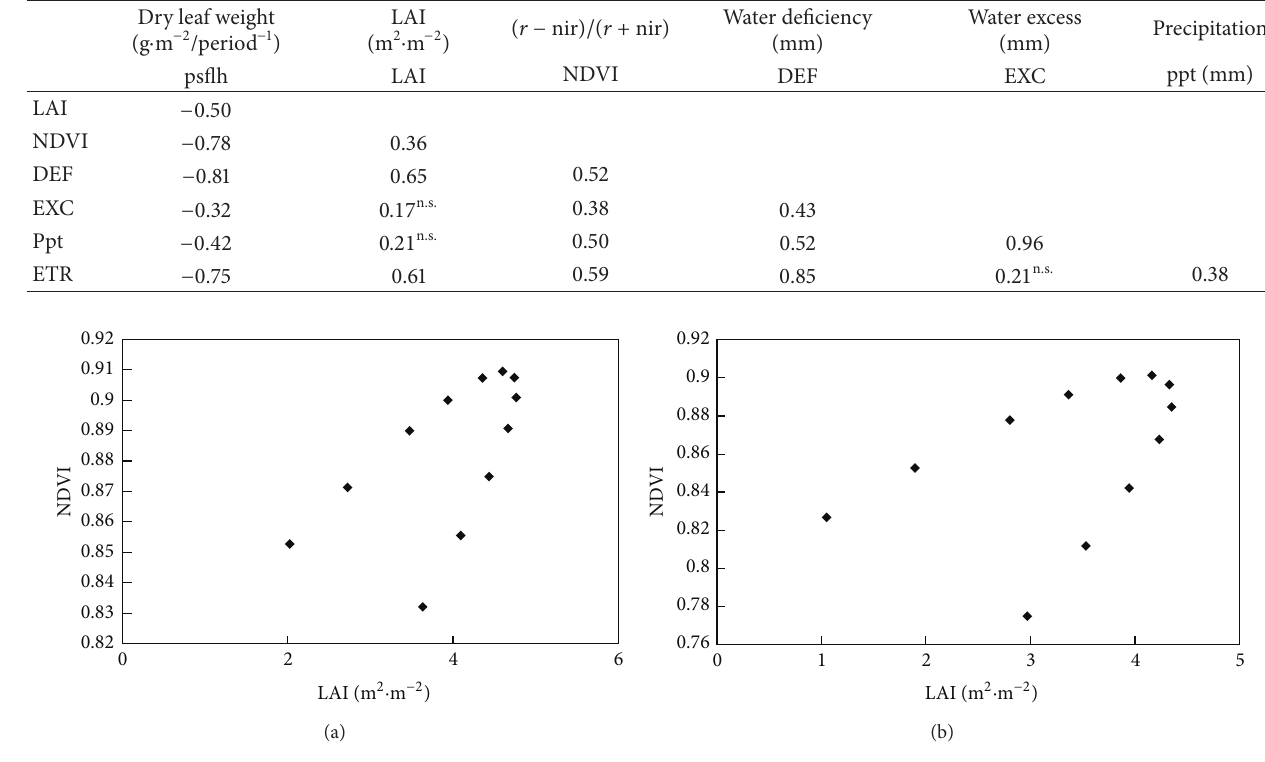
Figure 4: Temporal relation between LAI and NDVI with data adjusted by polynomial curves for Fragments 1 and 2.